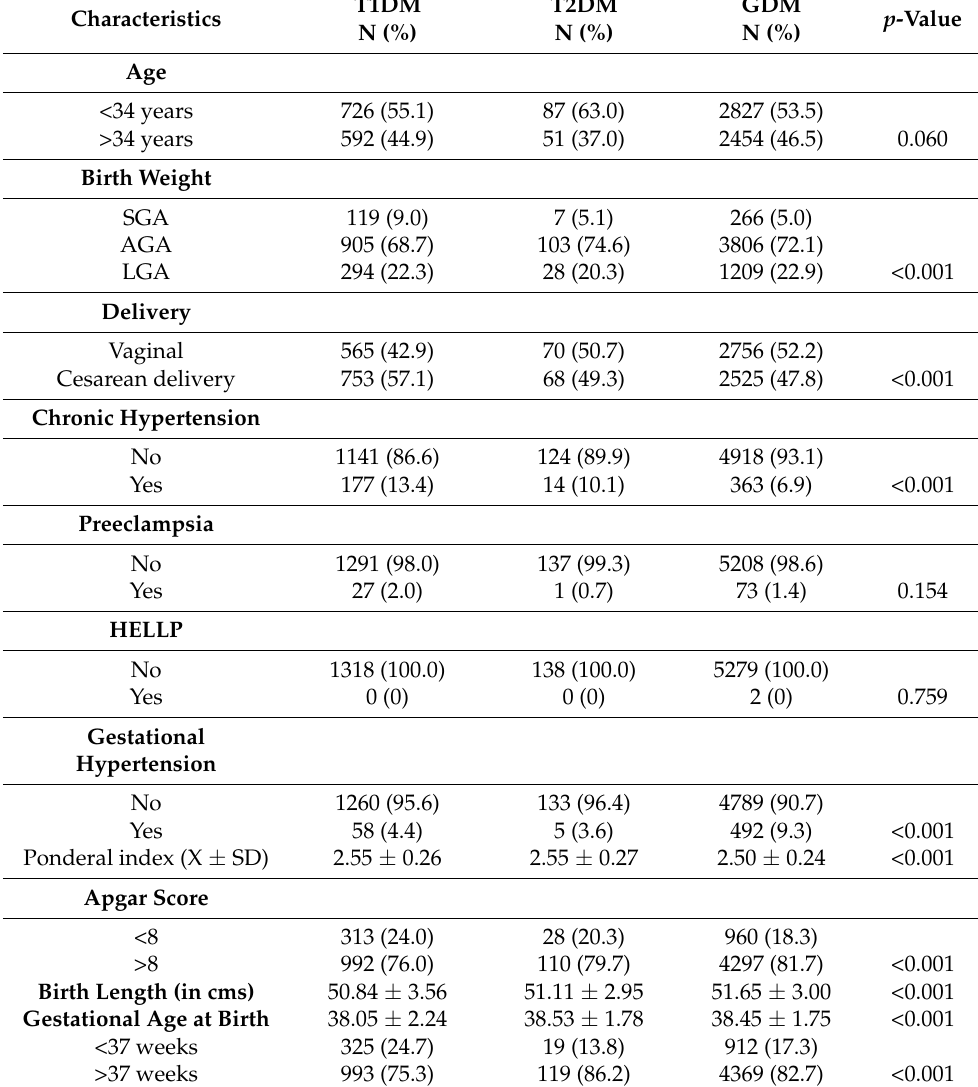
Table 1. Characteristics of womenin the three examined groups.